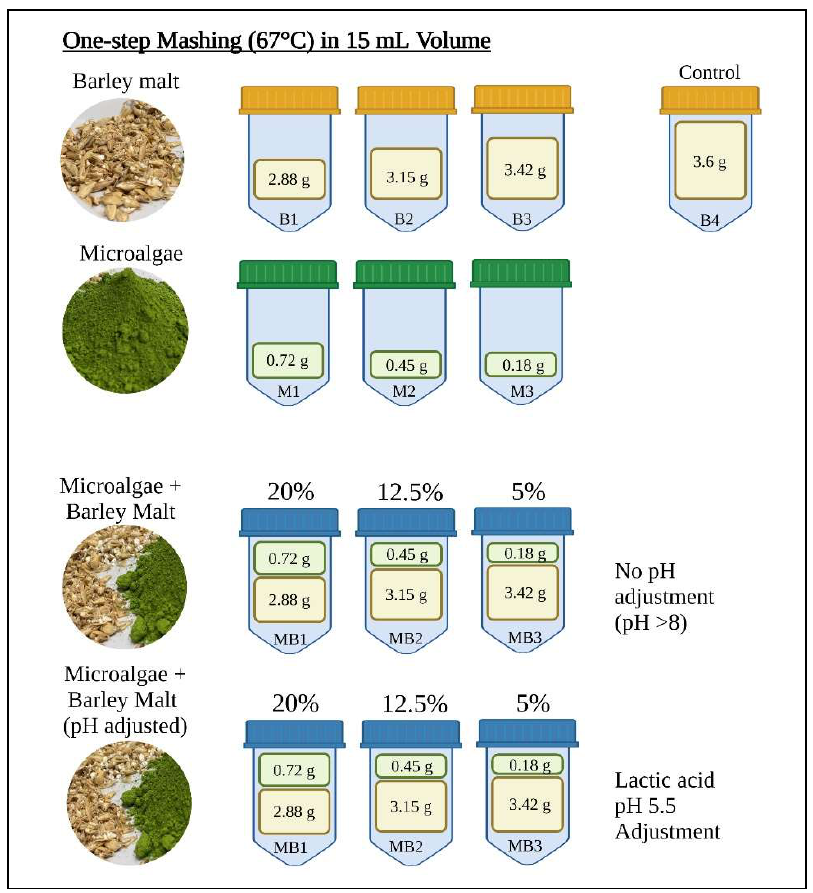
Figure 1. Mashing experiment design. Each tube represents a treatment (performed in triplicate). Yellow tubes (B1–4) represent barley malt mashing trials with content reported in grams; green tubes (M1–3) represent microalgae mashing trials with T. chui content reported in grams; blue tubes represent mashing trials with a mixture of barley malt and T. chui . Substitution of 20, 12.5, and 5% of the total solids with microalgal biomass, at a solid:liquid ratio of 0.24 kg L −1 , was performed with (MB1–3) and without (MB1–3) pH adjustment. Created with BioRender.com.